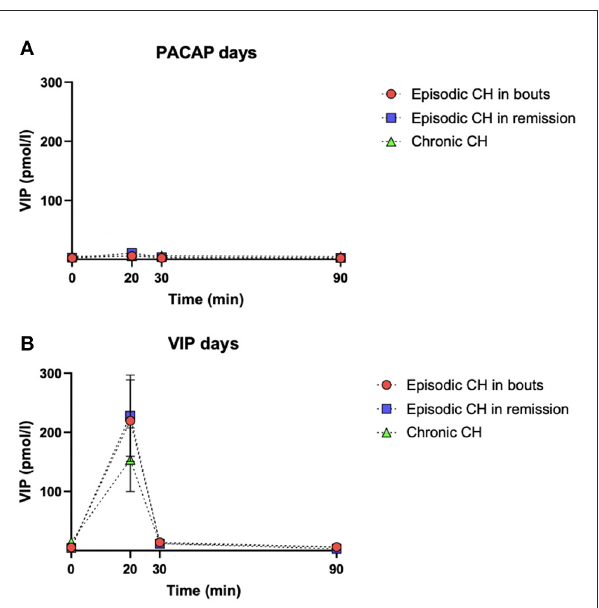
FIGURE3 Mean plasma levels and standard errors of VIP (pmol/l) for each study group during PACAP38 (A) and VIP days (B) . The dashed black line with red dots represents eCHA patients, the dashed black line with blue squares represents eCHR patients, and the dashed black line with the green triangle represents cCH